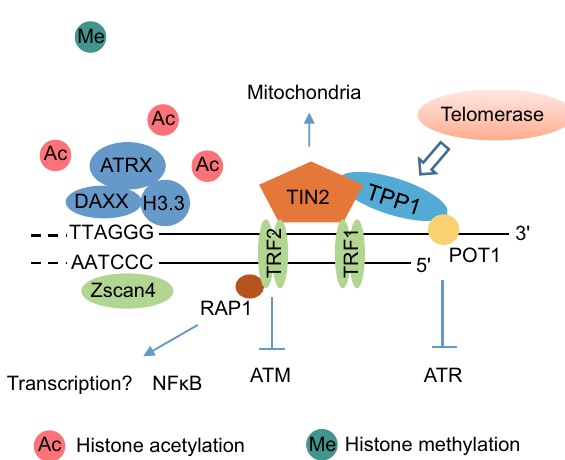
Figure 2. Organization and molecular functions of the telomere binding proteins and histone modi fi cations at hPSC telomeres. Telomeric DNA is protected from DNA damage response by the shelterin/telosome proteins: the double-stranded telomeric DNA binding factors TRF1 and TRF2, the single-stranded telomeric DNA binding factor POT1, the organizing factors TIN2 and TPP1, and the TRF2-binding factor RAP1. Telomerase is recruited by the shelterin complex to elongate telomeres. Some extra-telomere roles of shelterin/ telosome proteins are also shown as indicated. hPSCs show more open telomeric chromatin status, including more histone acetylation and less histone methylation. ATRX, DAXX and